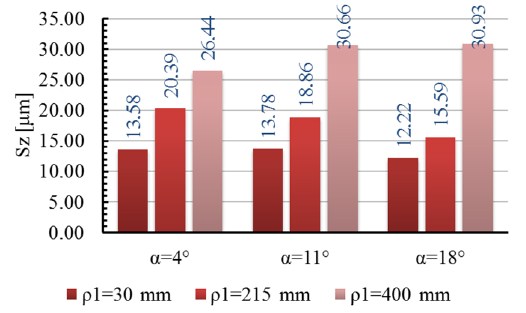
Figure 22. Statement of the measurement results of the parameter Sz of the convex surface of the turbine blade.